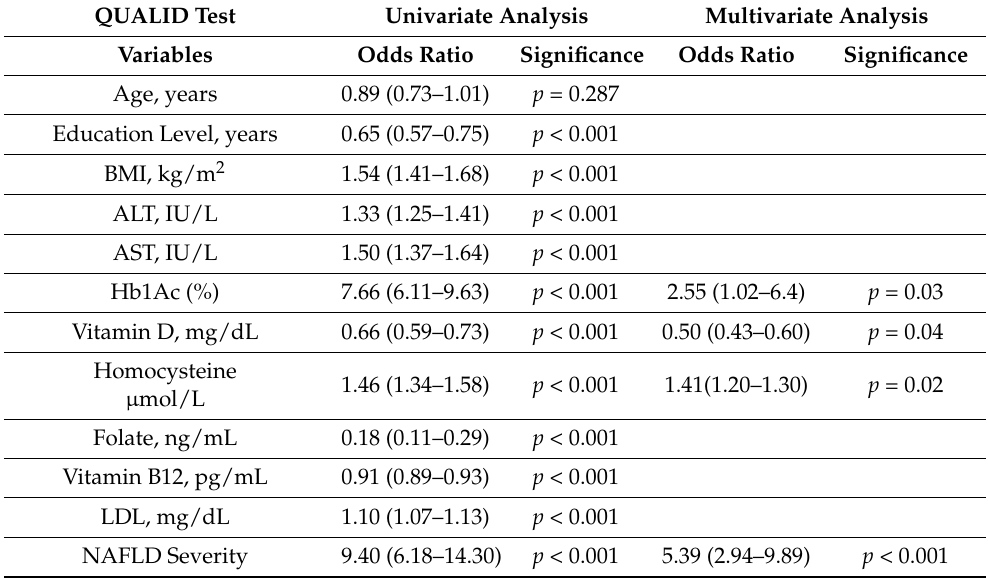
Table 5. Factors associated with worse QUALID test results in terms of Odds Ratio and its 95% C.I. Variables are initially studied univariately and then multivariately by choosing the model with the lowest